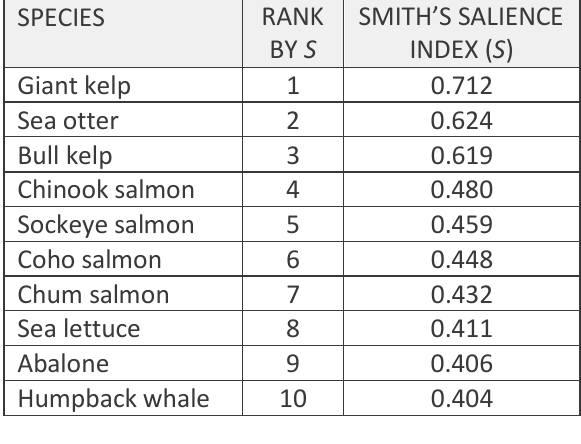
Table (cid:4)(cid:1008) .1